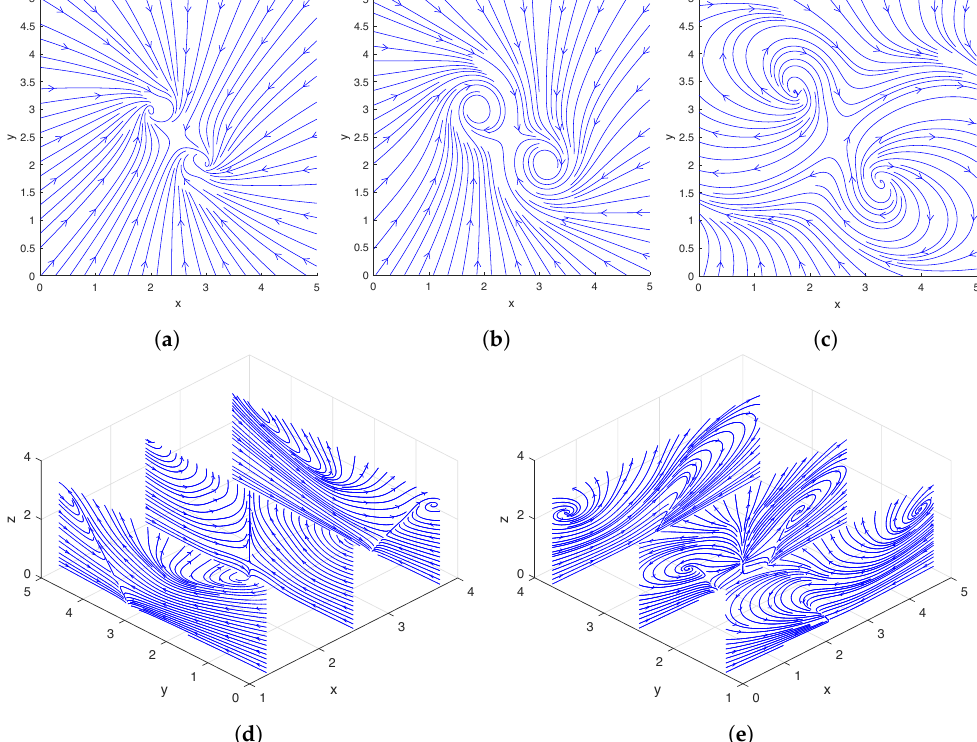
Figure 6. Streamlines drawn from the flow around a pair of rotating helices at the midpoint of a cycle. The locations and phase shifts of the helices are shown in Figure 7b. Top row: Streamlines plotted using only the x - and y -direction fluid velocities on the slice planes located at z = 0.1 ( a ), z = 1.1 ( b ), and z = 2.5 ( c ). Bottom row: Streamlines plotted using only the y - and z -direction fluid velocities on the slice planes located at x = 1.25, 2.5, 3.75 ( d ); streamlines plotted using only the x - and z -direction fluid velocities on the slice planes located at y = 1.25, 2.5, 3.75 ( e ). Table 7. The runtimes, iteration counts, and numbers of function evaluations entailed by the hybrid method for the case of a pair of helices and three sizes of the flow meter (7): W = 2.5, 5, and 10. (Forty-eight computer cores are